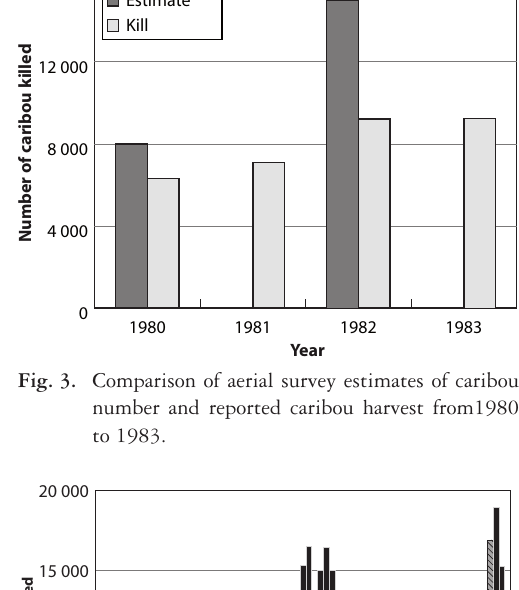
Fig. 3. Comparison of aerial survey estimates of caribou number and reported caribou harvest from1980 to 1983.